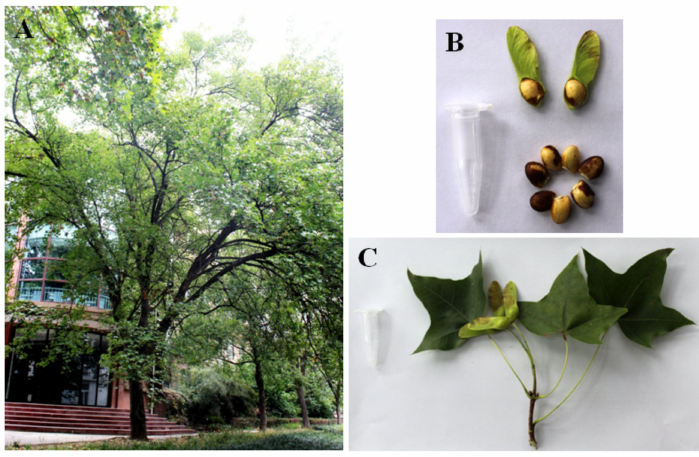
Figure 1. The adult tree ( A ), seeds ( B ) and leaves ( C ) of Acer truncatum in Yangling, Shaanxi province,